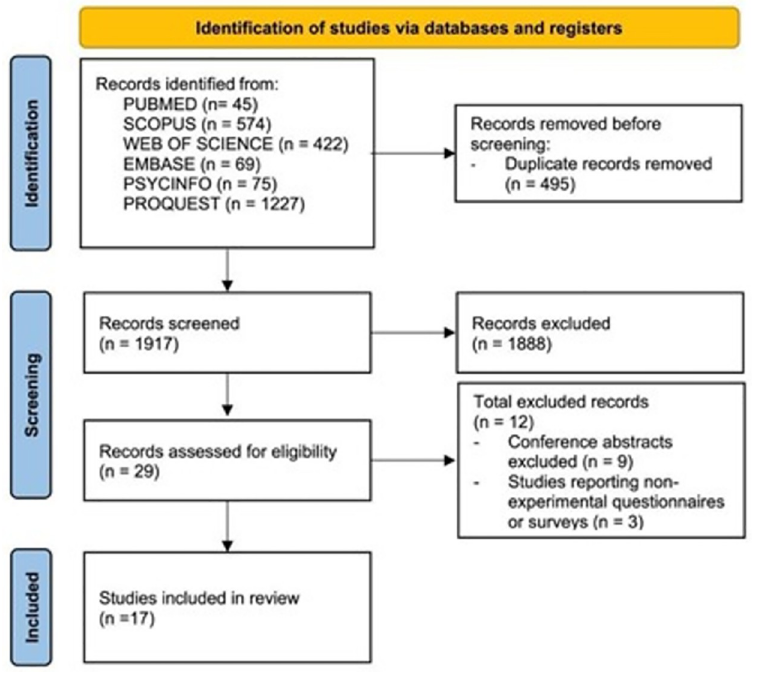
Fig 2. PRISMA flow diagram summarizing the selection